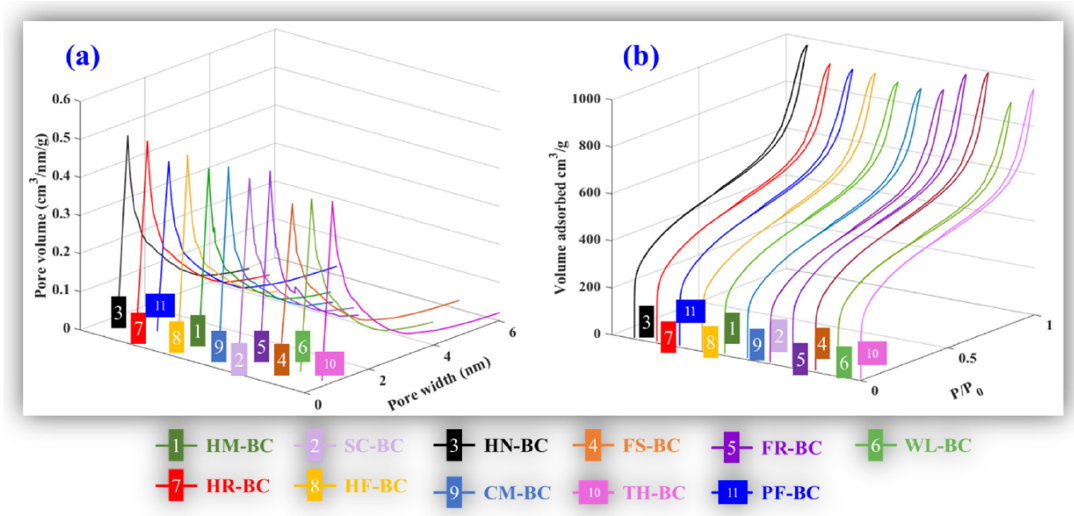
Figure 2. The pore size distributions ( a ) and N 2 adsorption / desorption isotherms ( b ) of the AKWs-BC and TH-BC.